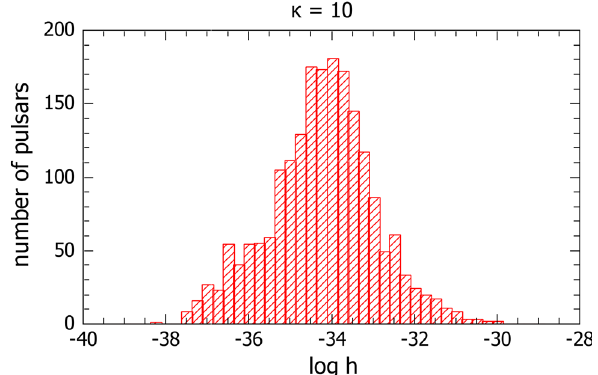
Fig. 4 Correlation between the efficiency and the period for all pulsars with known P , ˙ P